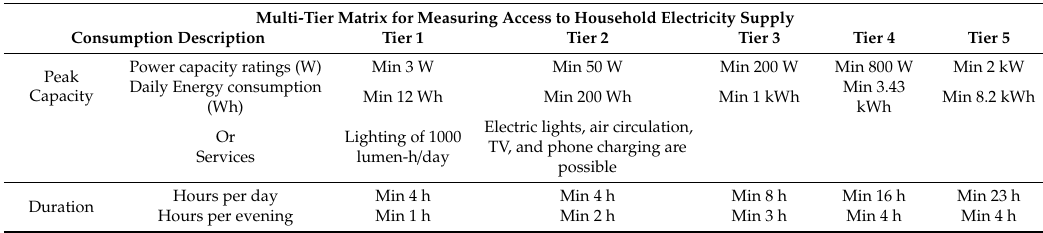
Table 1. The World Bank electricity end-user